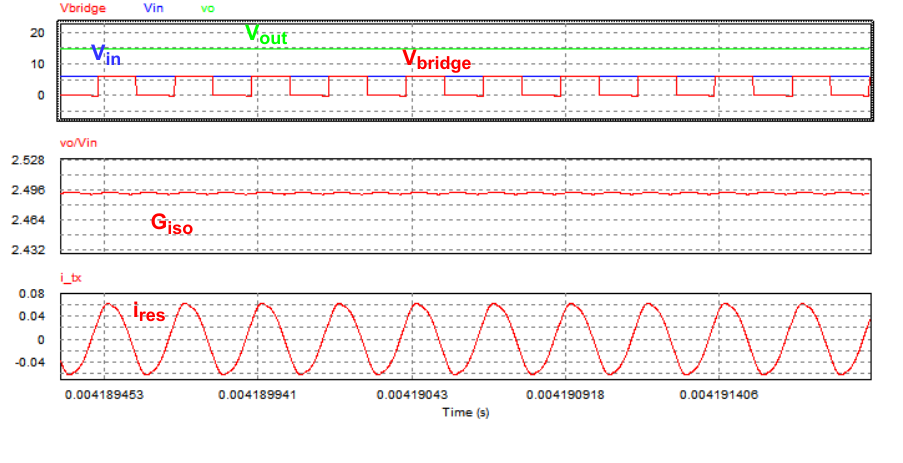
Figure 9. PSIM simulation